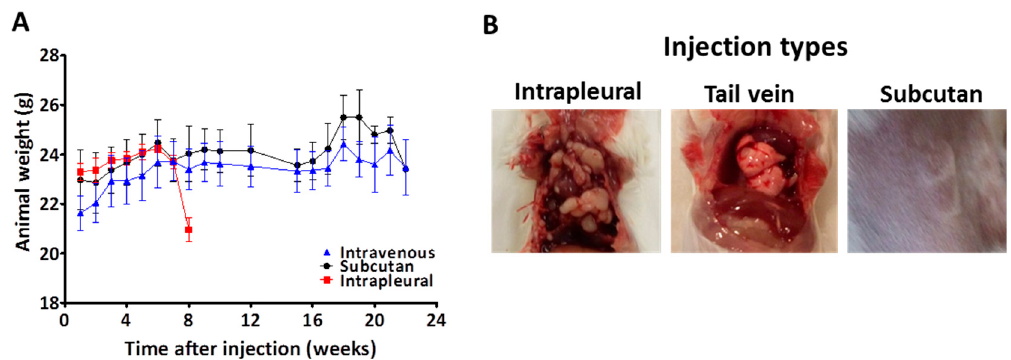
Figure 4. In vivo tumorigenicity of PF130 cells. ( A ) Cells were injected into female SCID mice subcutaneously ( n = 3), into the tail vein ( n = 4) or intrapleural ( n = 3). The weight of the animals was measured once a week. ( B ) The injection into the thoracic cavity led to robust tumor growth within two months. In contrast, tail vein and subcutaneously injected cells survived but the tumor load was minimal even after six